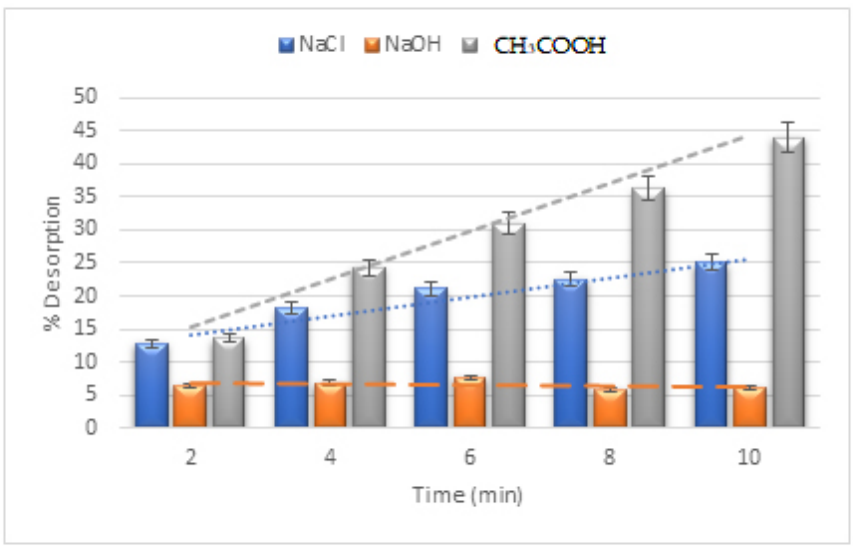
Figure 8. Desorption of CV dye in various media.